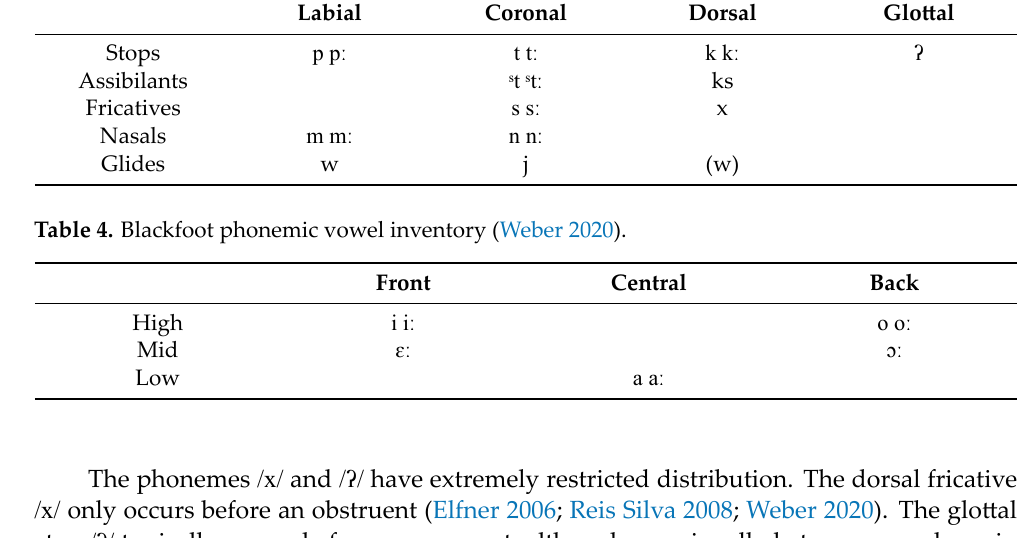
Table 3. Blackfoot phonemic consonant inventory (Weber 2020).